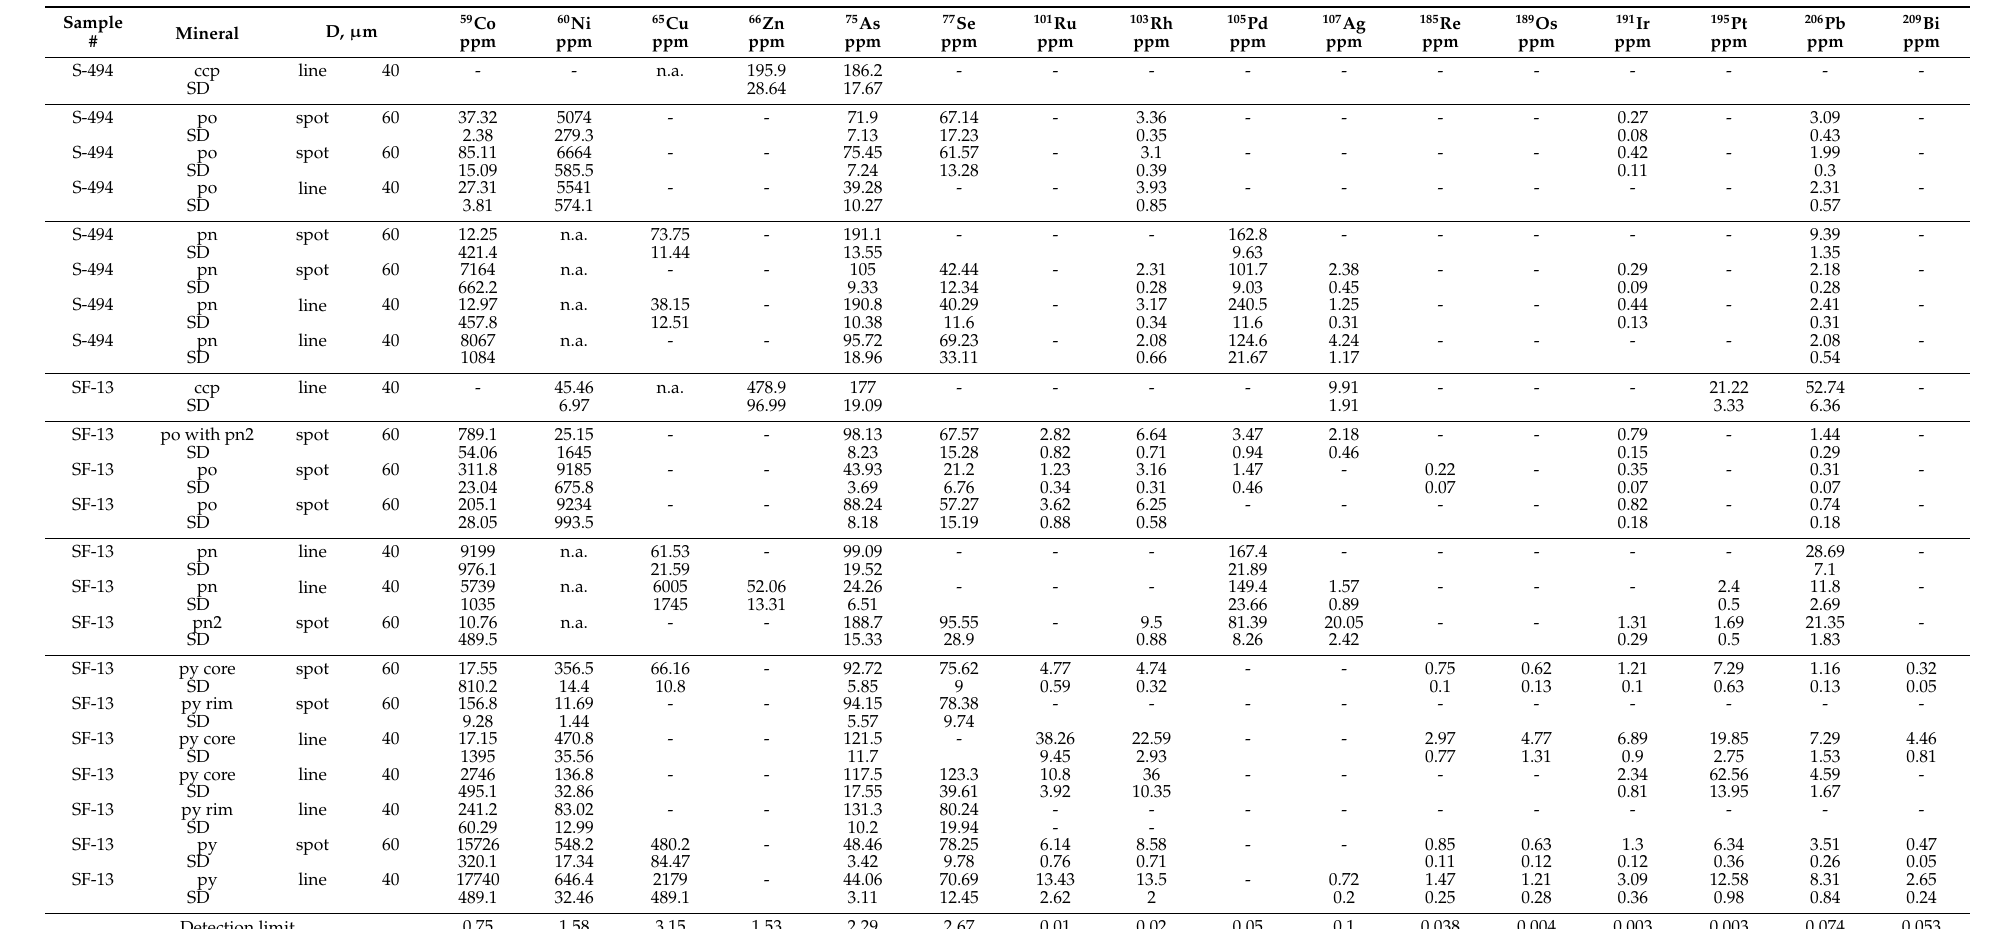
Table 7. Trace element contents in sulfides, as determined by